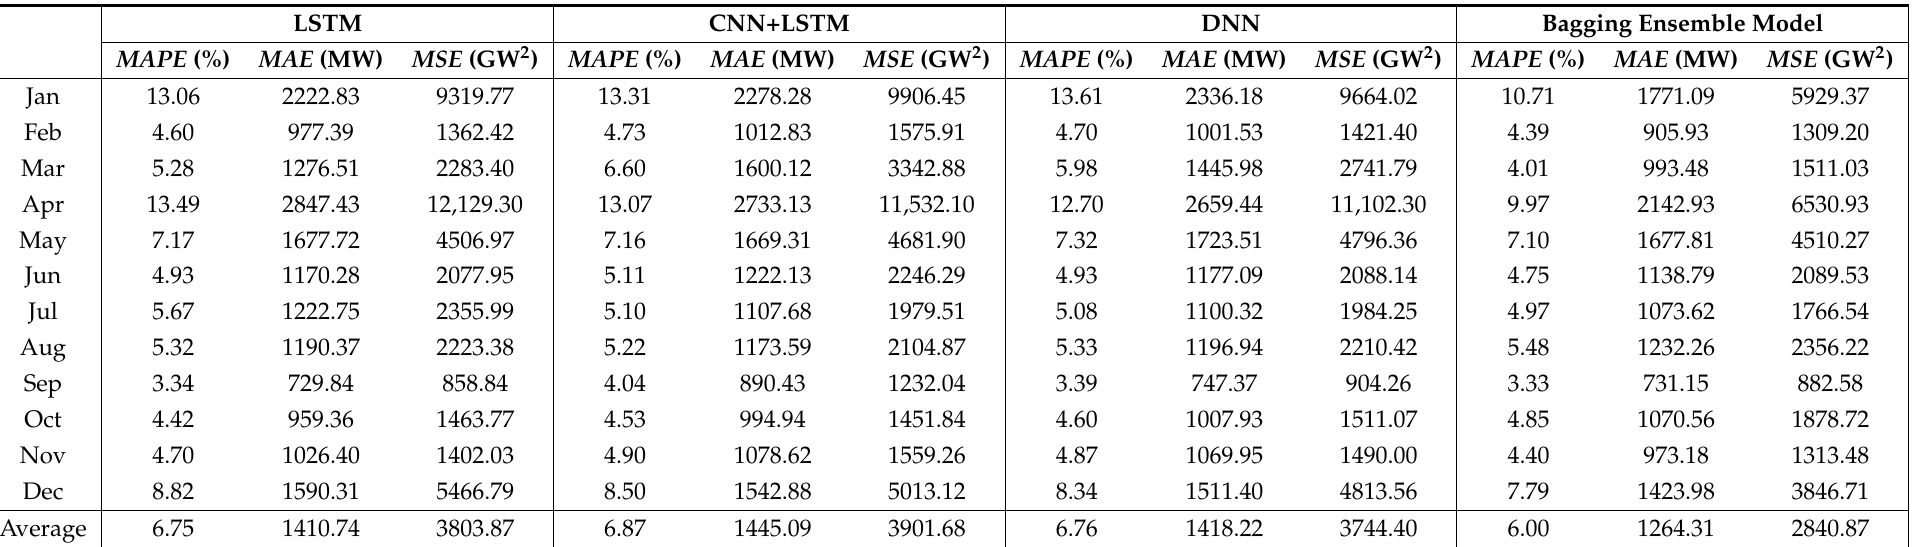
Table 5. Error Measurements of Test Data for Ten Input Features in 2021.